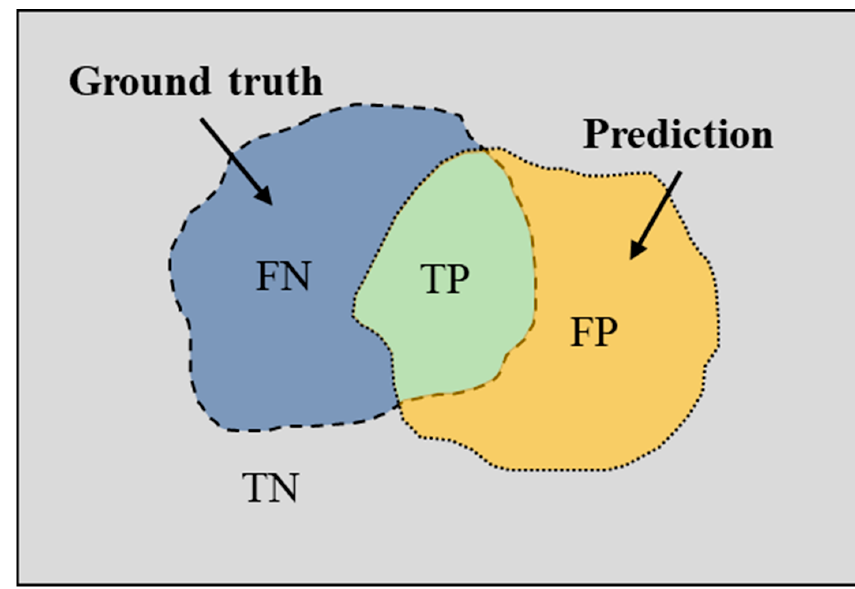
Figure 9. Relational diagram of the TP, TN, FP, and FN indicators.